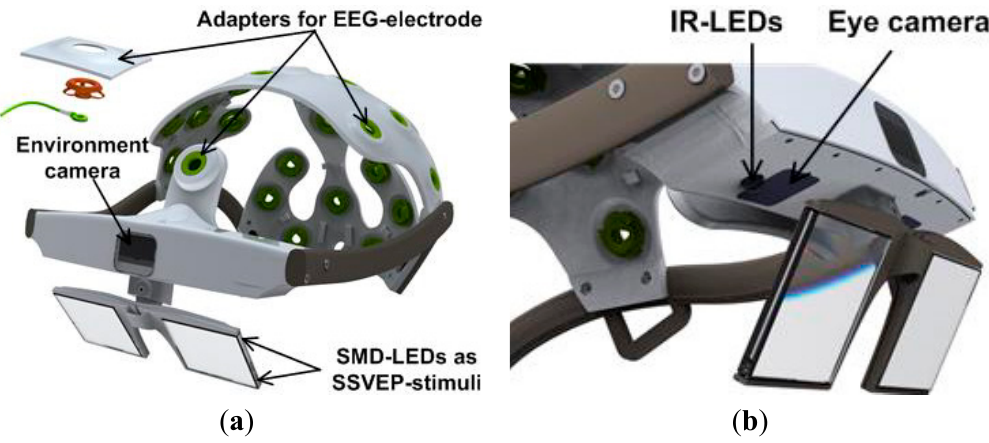
Figure 5. sBCI headset which includes a hard case cap with 22 EEG electrode positions ( a ) two eye cameras, one camera for observation of the environment and four SSVEP-stimuli at the edges of the infrared mirrors ( b